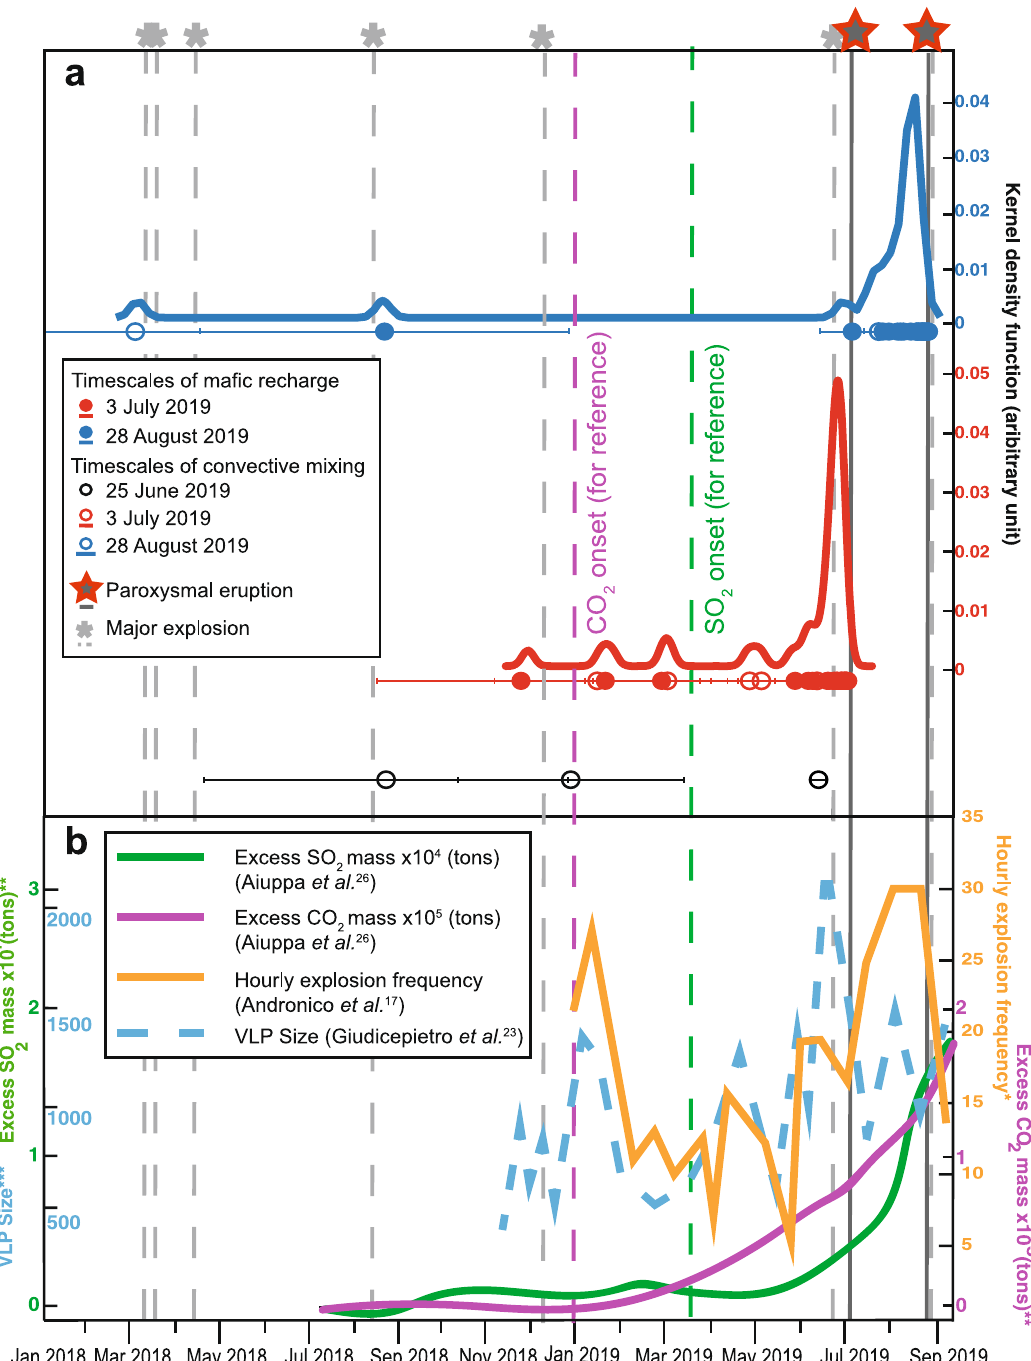
Fig. 8 | Relationship between timescales of ma fi c recharge events and mon- itoring dataforthe2018- 2019period.a Kerneldensity estimates of timescales of magmarecharge(subgroups1B,1CandGroup2; fi lledcircles)andconvectivemixing in the shallow hp- reservoir (subgroup 1A; open circles) during the January 2018 — August 2019 period for the two paroxysmal events (3 July, red curve and circles and 28Augustbluecurveandcircles)areshownalongsidethetimescalesdeterminedfor themajorexplosionon25June2019(blackcircles).Timescalesofconvectivemixing for the 25 June major explosion are shown as single data (black open circle) due to